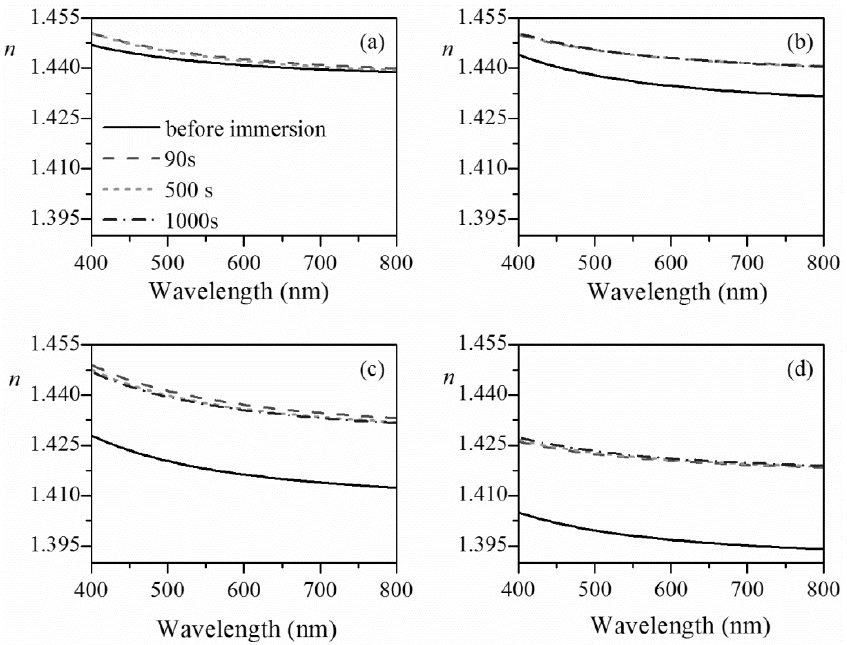
Figure 4. Dispersion curves of refractive index of TEOS-only films annealed at 170 ◦ C ( a ) and 320 ◦ C ( b ) and TEOS-LTL films annealed at 170 ◦ C ( c ) and 320 ◦ C ( d ) immersed in water for the denoted duration. The reference curve of refractive index of the layers prior to immersion is also plotted (solid black line). Table 1. Calculated thickness values (in nm) and thickness change Δ d = ( d 1000s − d 90s ) /d 90s of undoped (TEOS-only) and doped (TEOS-LTL) films annealed at 170 and 320 °C after immersion in water for 90, 500 and 1000 s.